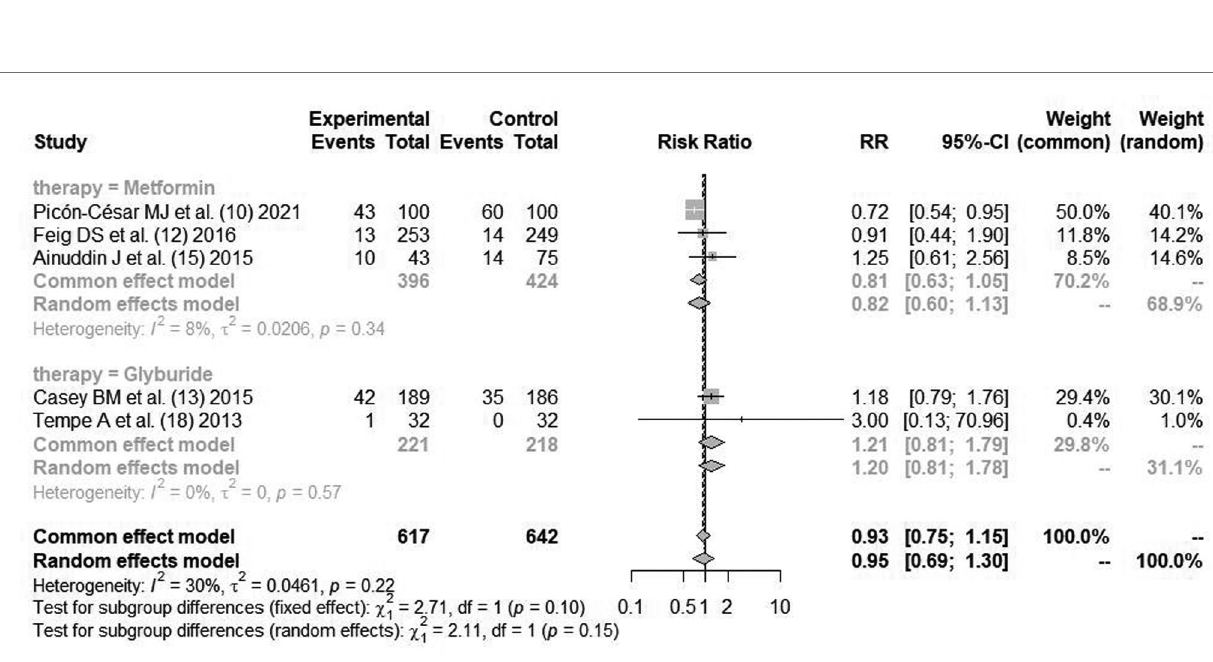
FIGURE 5 | Comparison of maternal weight gain after blood glucose control during pregnancy.